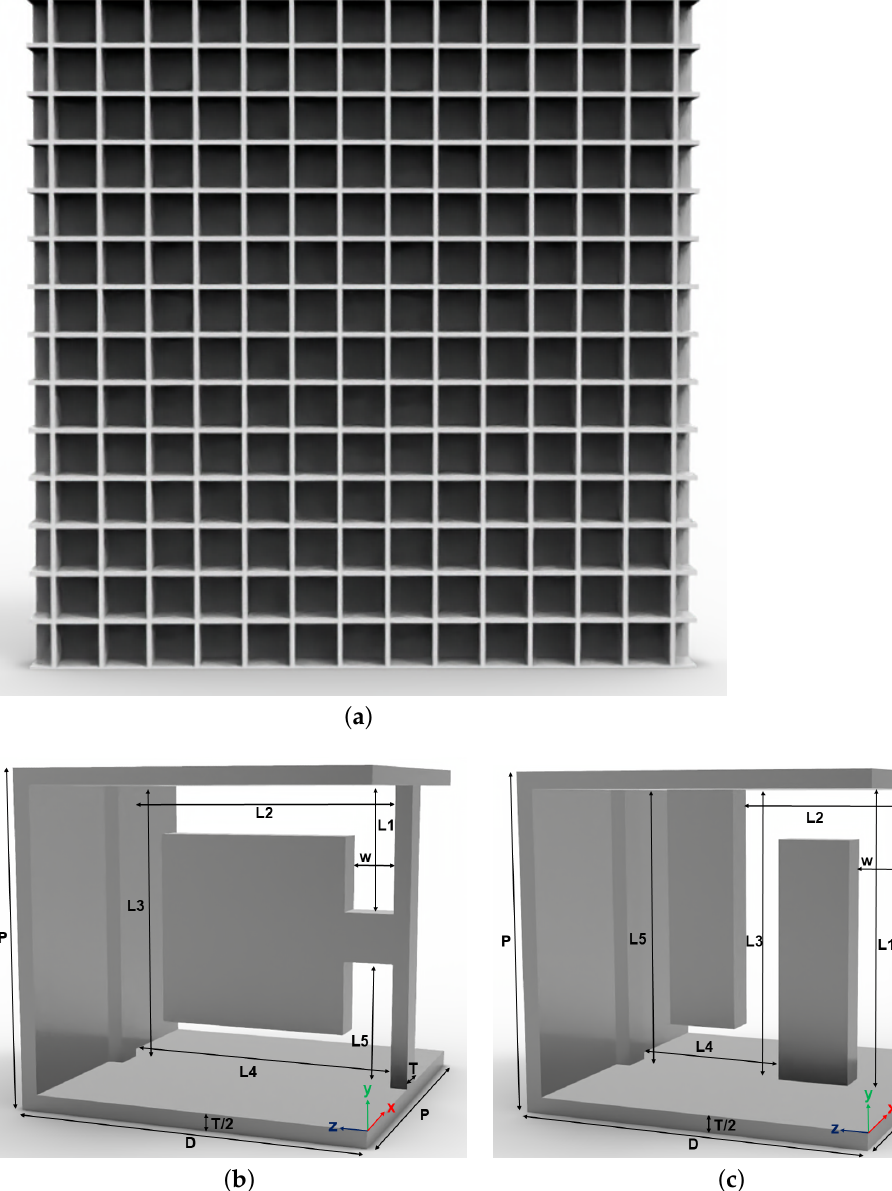
Figure 1. ( a ): Array 14 × 14 square waveguides. ( b ): Unit-cell type with a C-shaped resonator on the wall and dimensions. ( c ): Unit-cell type with an S-shaped resonator on the wall and dimensions. The length of the slot perforation is calculated as L = L 1 + L 2 + L 3 + L 4 + L 5